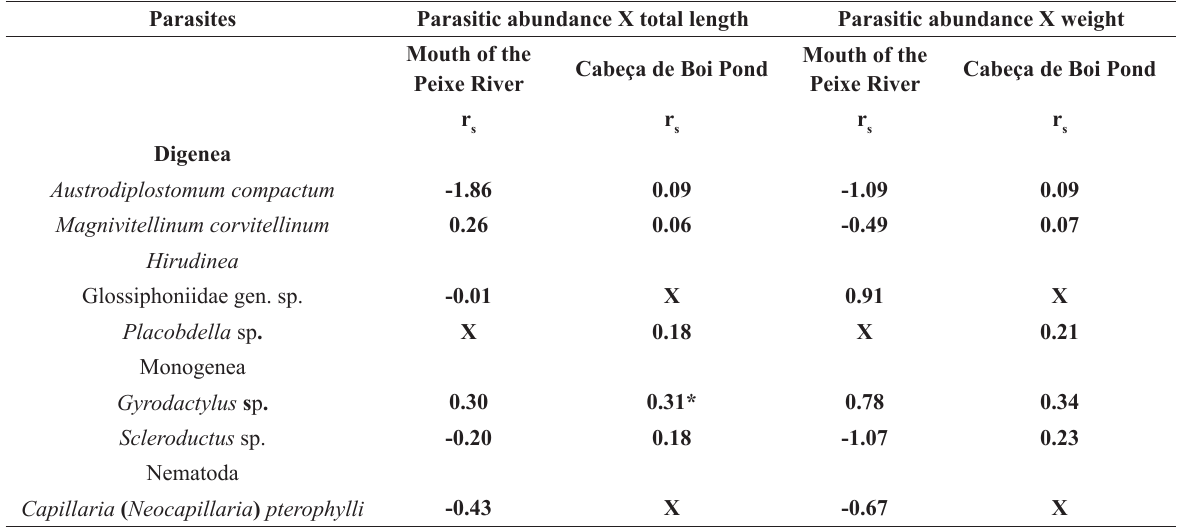
Values of the correlation coefficient by the Spearman rs to assess possible correlations between the parasitic abundance and the total length of Hoplosternum littorale (Hancock 1828), the parasitic abundance and the weight of these hosts collected in the Peixe River, Middle Tietê River, São Paulo, Brazil.